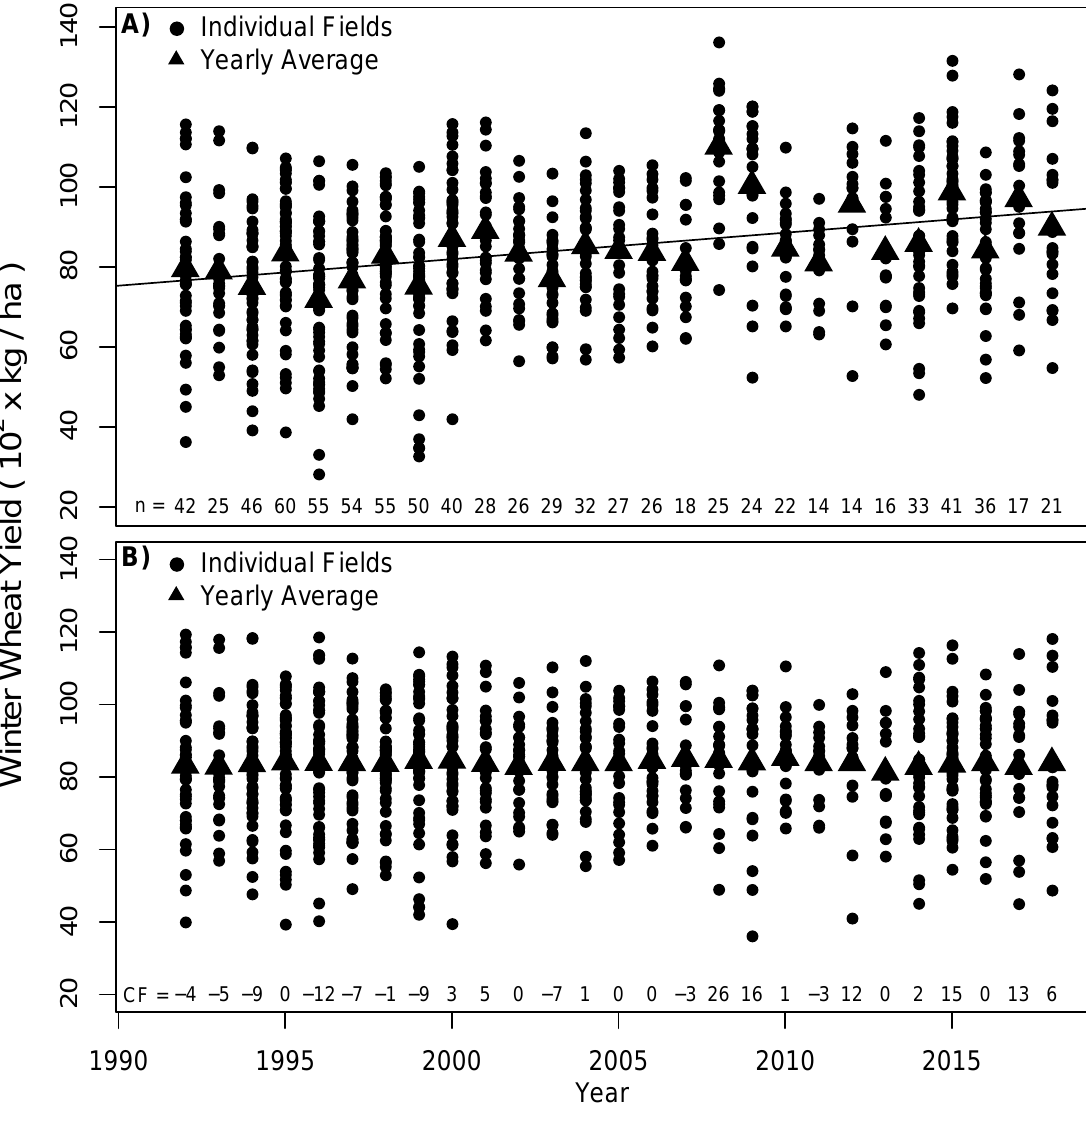
Figure 2. ( A ) Yield from winter wheat fields exhibiting a positive increase through the years and ( B ) yield detrended by subtracting a correction factor (CF; yearly average – global average) from individual fields to remove temporal